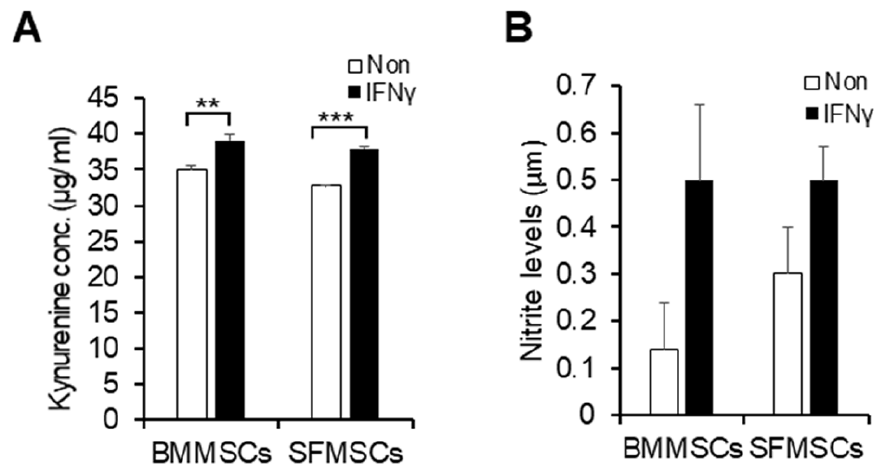
Figure 6. Indoleamine-2,3-dioxygenase (IDO) and nitric oxide (NO) expressions in the conditioned medium stimulated with interferon-gamma (IFN- γ ). ( A ) Kynurenine assay, the functional IDO activity was evaluated by measuring the content of kynurenine in the conditioned media of BMMSCs and SFMSCs stimulated with IFN-γ (100 ng/mL) for 48 h. ** p < 0.01, *** p < 0.001. ( B ) Concentration of nitrite following stimulation with IFN-γ for 48 h. All values represent mean ± SD ( n = 3). Statistical analysis was carried out using the Student’s t-test with p < 0.05 as significant. Experiments were performed on cells from three different donors ( n = 3), each in triplicate.